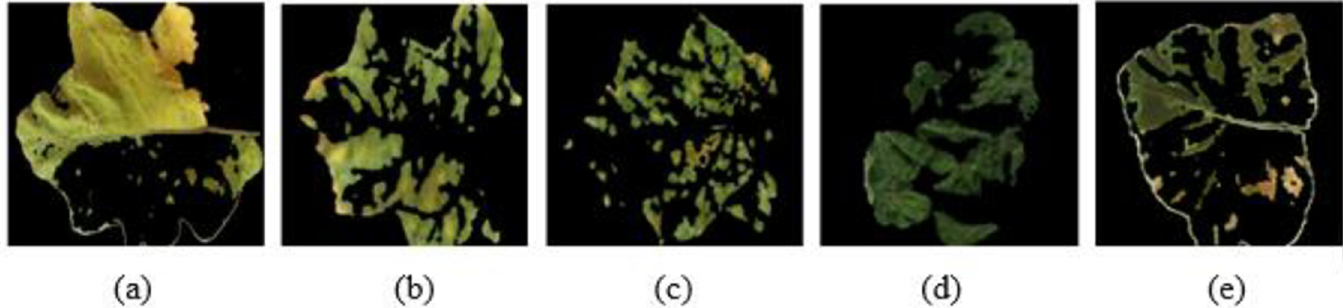
PLOS ONE | https://doi.org/10.1371/journal.pone.0284021 April 5,